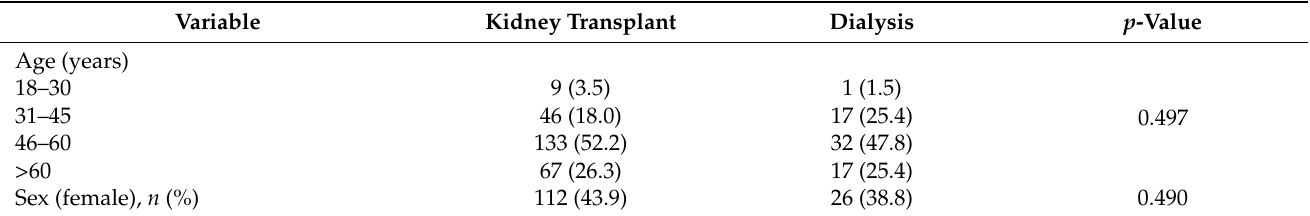
Table 1. Participant